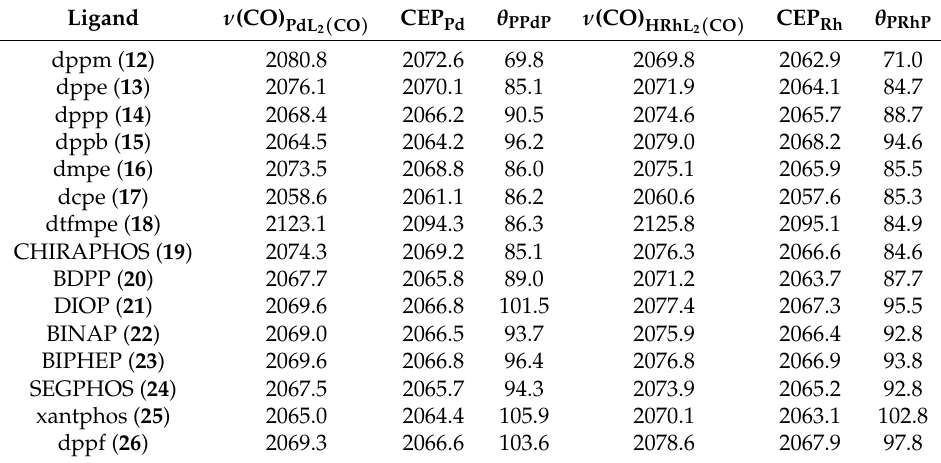
Table 2. Computed CO-stretching frequencies and P-M-P bite angles ( θ PPdP and θ PRhP , in degrees) for diphosphine-containing complexes PdL 2 (CO), HRhL 2 (CO), and their respective Computed Tolman Parameters (CEPs), determined according to Equations (5) and (6). Vibrational frequencies are in cm − 1 .